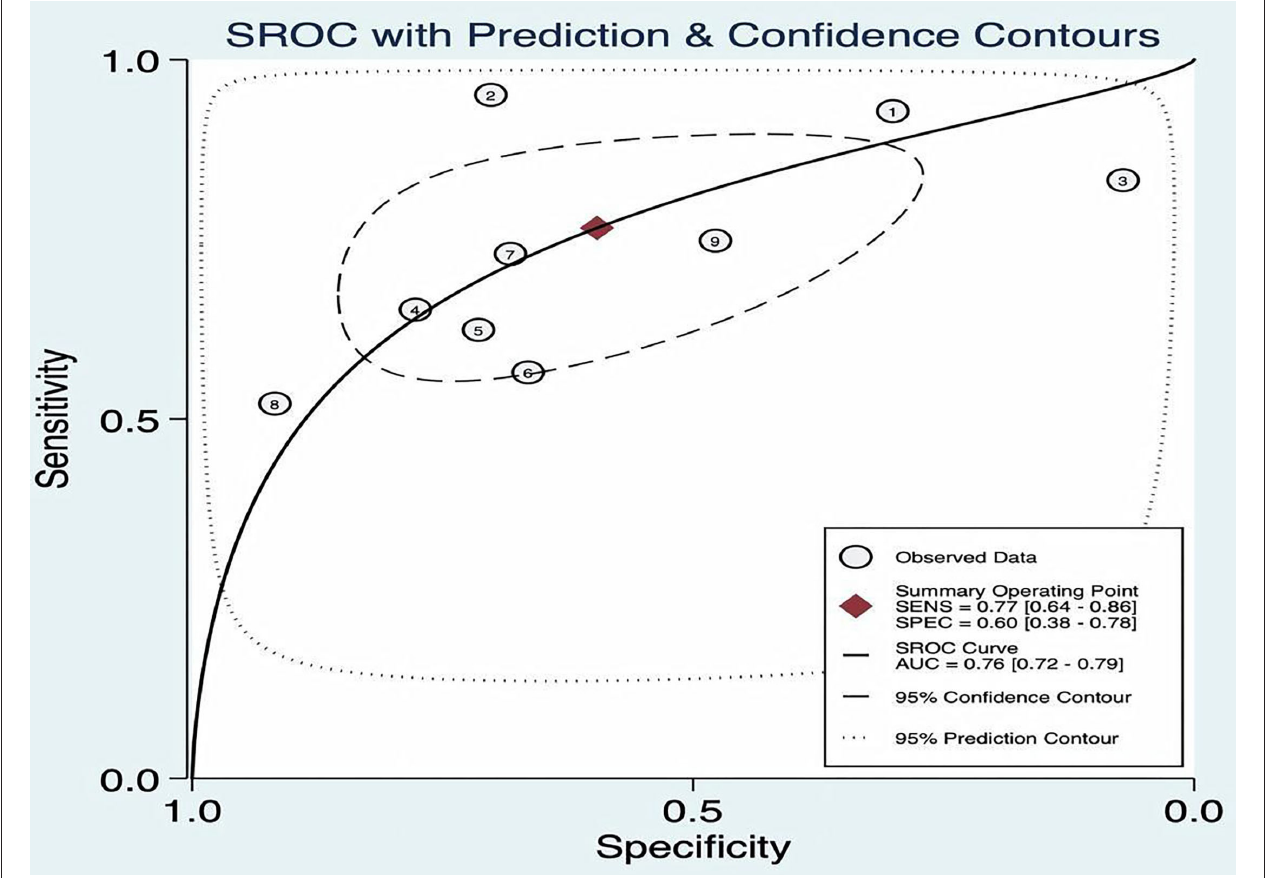
FIGURE 4 | Summary receiver operating characteristic (ROC) of